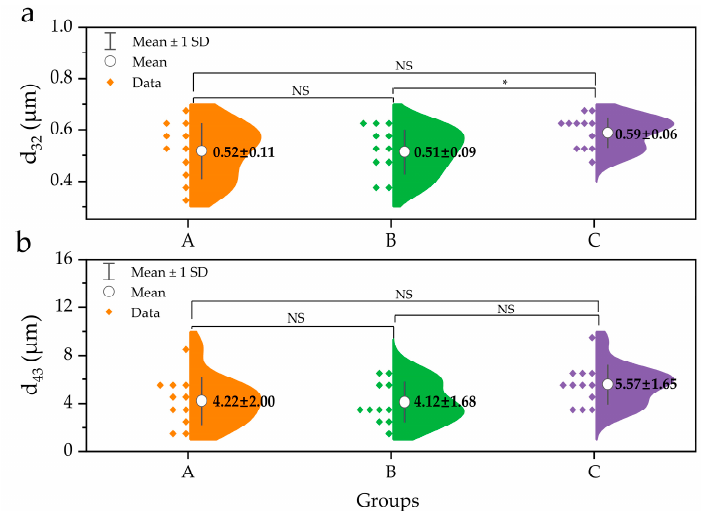
Figure 2. Size comparison of human milk fat globule in different groups. ( a ) d 32 , surface-weighted mean diameter; ( b ) d 43 , volume-weighted mean diameter. * represents a significance of difference at p < 0.05. NS represents non-significant difference ( p > 0.05). A group, n = 11; B group, n = 11; C group, n = 12.